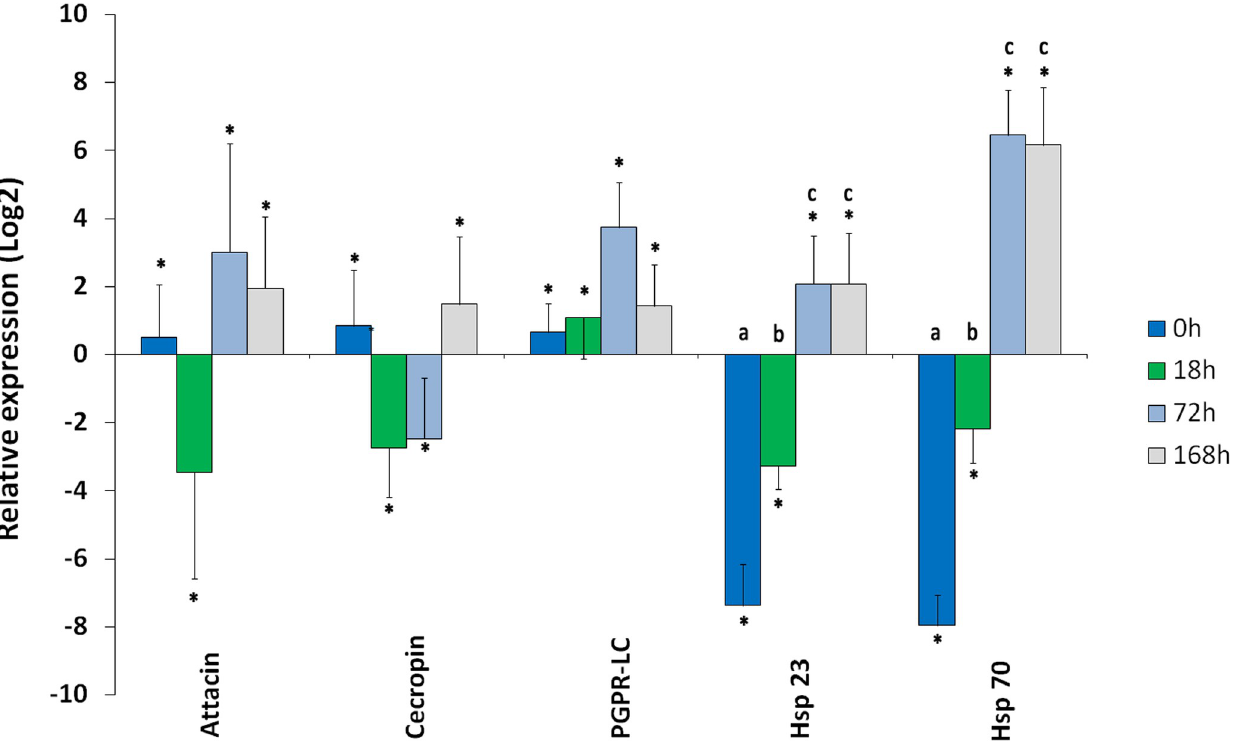
Fig 2. Relative level of expression of attacin , cecropin , PGRP-LC , hsp23 , and hsp70 genes determined by qRT-PCR. Barplots showing relative genes expression as means SD of log fold changes from irradiated pupae and sterile adult males aver time compared to the non-irradiated ones. The mRNA level of G6PDH and GAPDH2 transcripts were used to normalize the expression level of candidate genes. Differences in mRNA expression level were analyzed using Multifactor ANOVA followed by LSD to discriminate means at the 95% confidence level. Standard errors across replicate trials are plotted in the graph. Different letters indicate for each gene statistical differences (P � 0.05) observed between means. Symbol ( � ) above bars indicate for each gene statistical differences (P � 0.05) observed with untreated control.